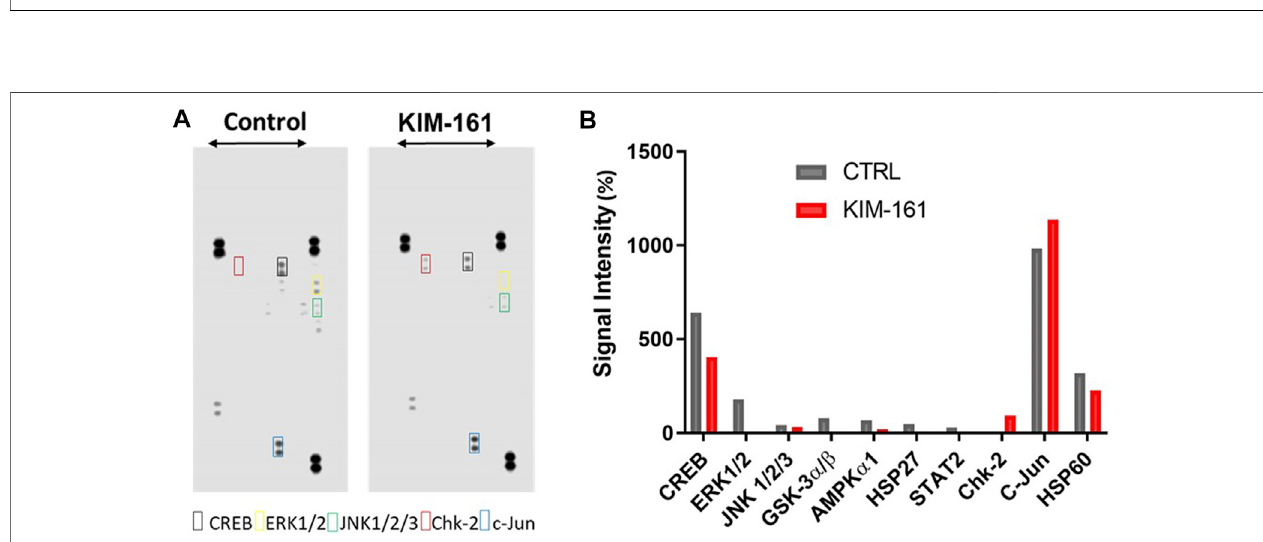
FIGURE 8 | Phosphokinase proteome pro fi le of KIM-161 in HL60 cell line. (A) Cells lysates were prepared after 10 h treatment with KIM-161 and applied to the membranes prespotted with the different antibodies. (B) The bar graph shows variation of phosphokinases in HL60 cells upon KIM-161 exposure relative to the untreated control cells. The height of each bar represents the average intensity of certain protein signals in treated cells/untreated × 100. Therefore, the dotted line represents the control percentage (100%).